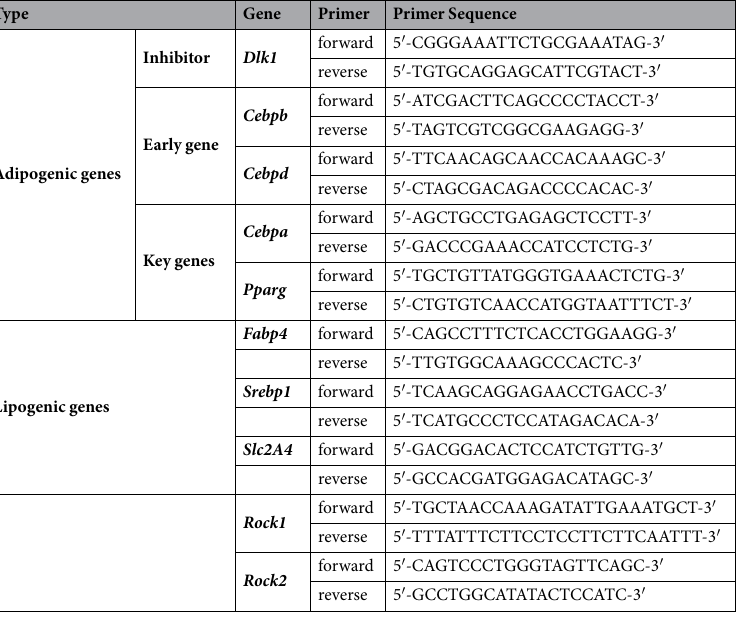
Table 1. List of real time PCR primers and